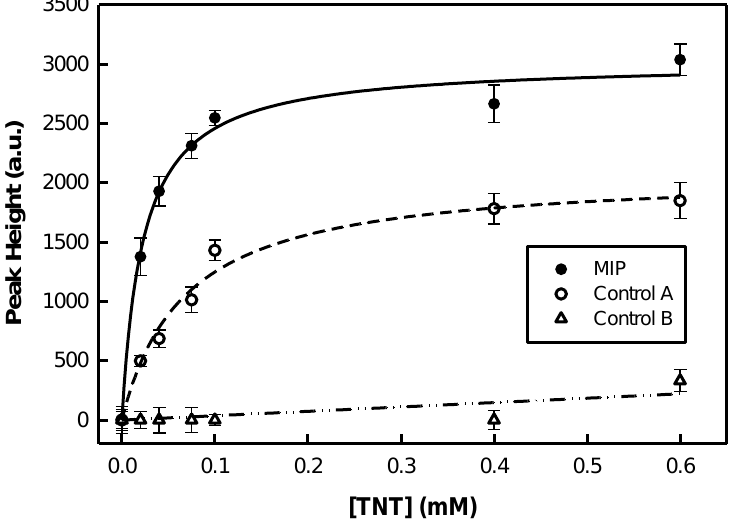
Figure 8. Response profiles for a MIP and control A and B films integrated with a Klarite ®